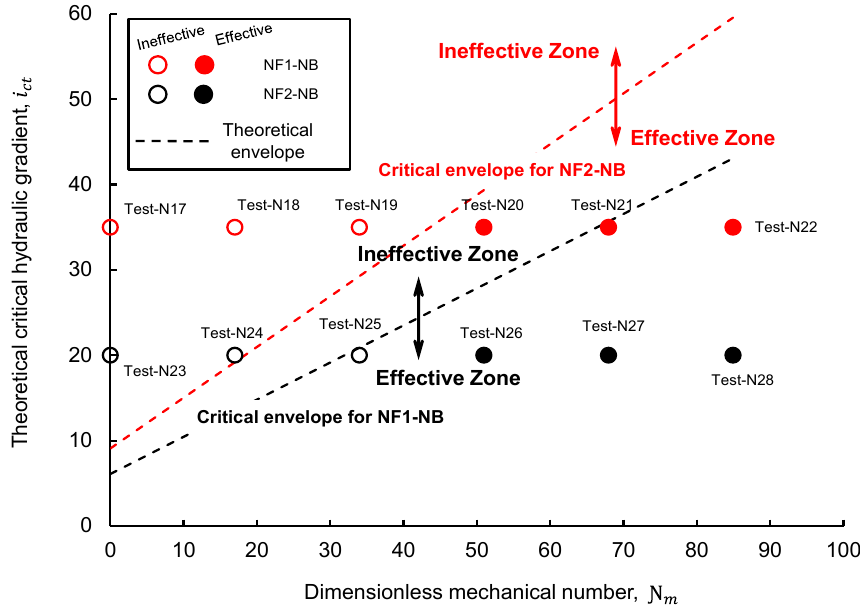
Figure 10. Validation through coupled CFD-DEM simulation results (test series numbers in Table 2 for data).